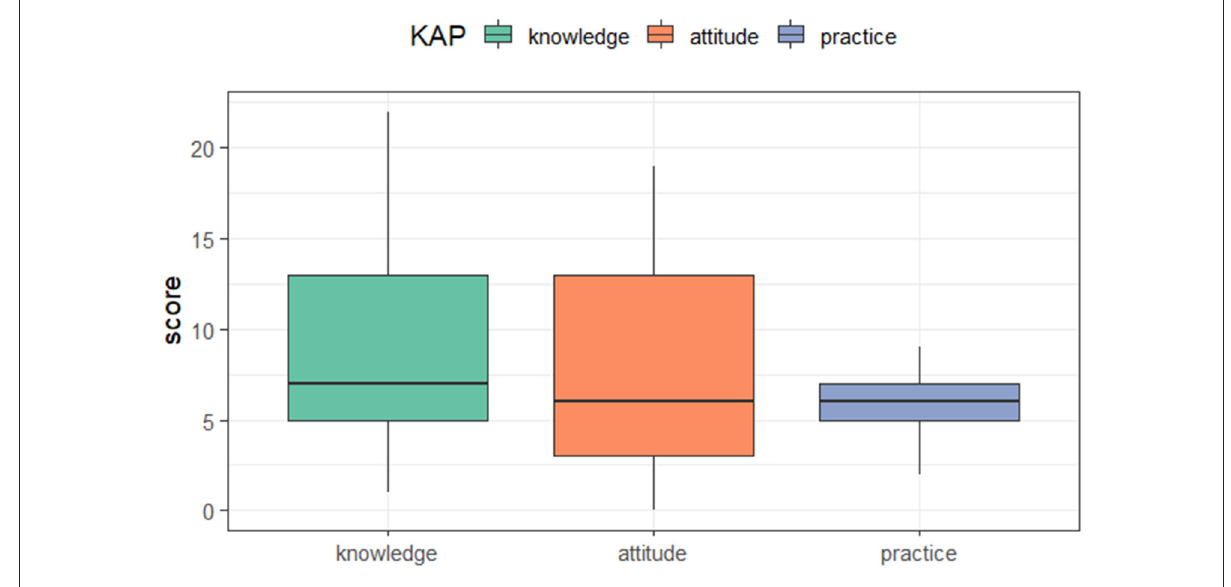
FIGURE1 The distribution of KAP score.